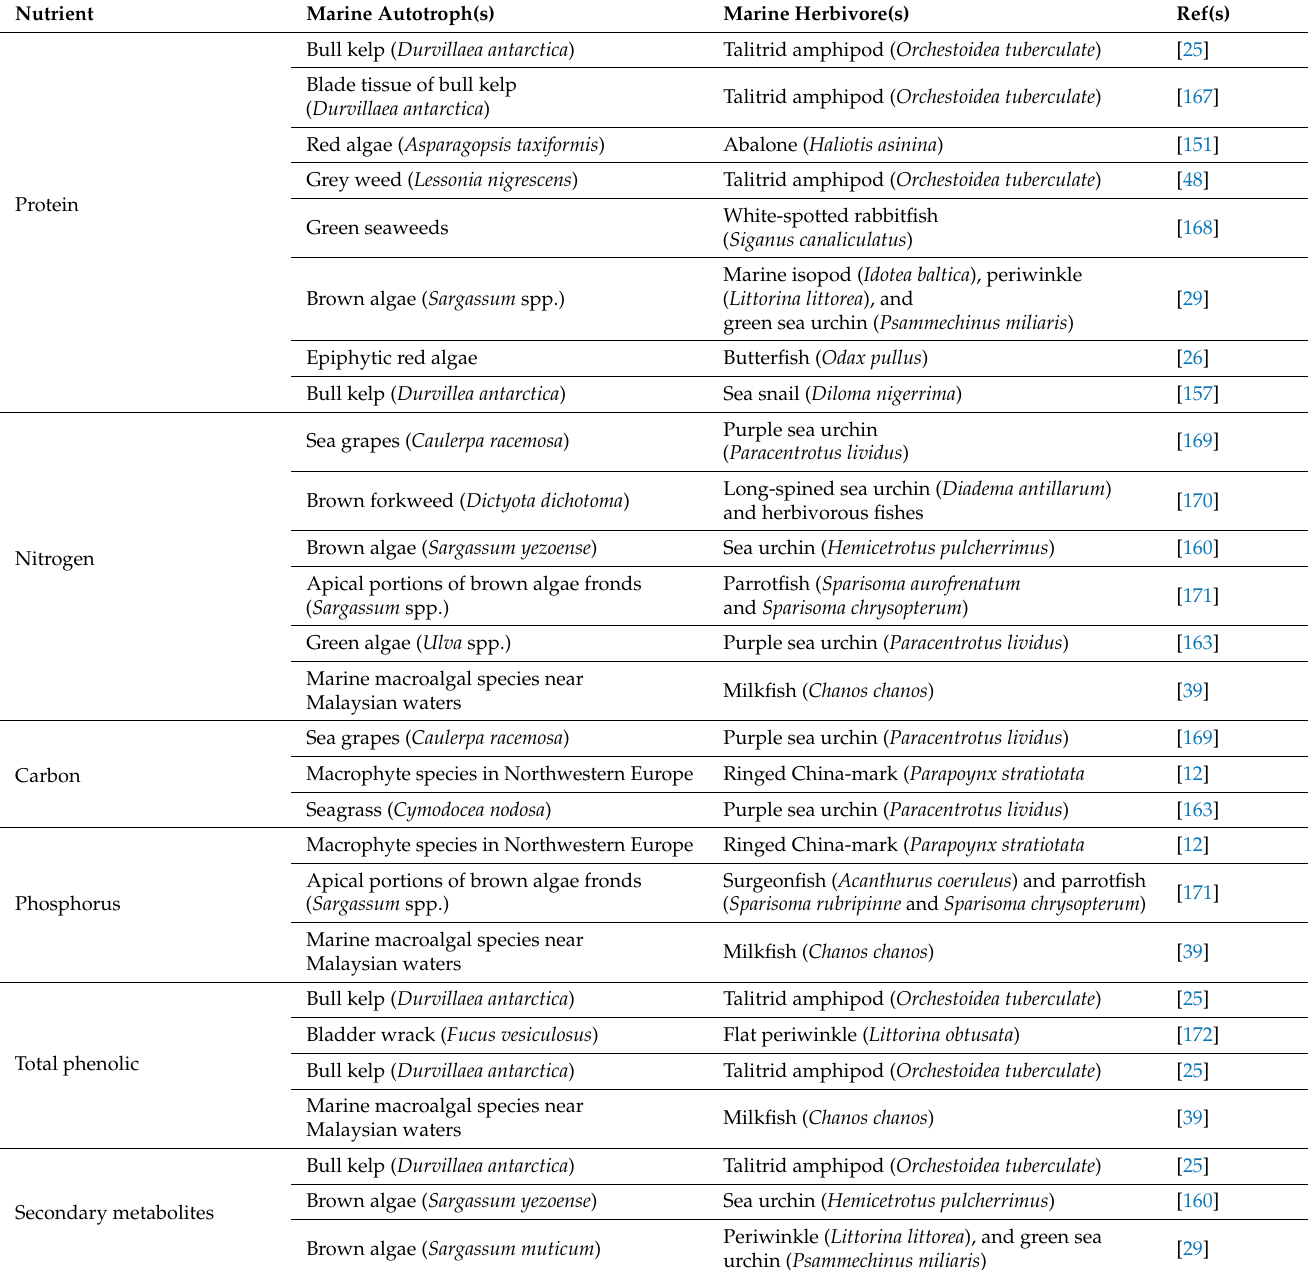
Table 3. Examples of studies involving marine autotroph-herbivore interactions based on herbivore nutrient acquisition since the